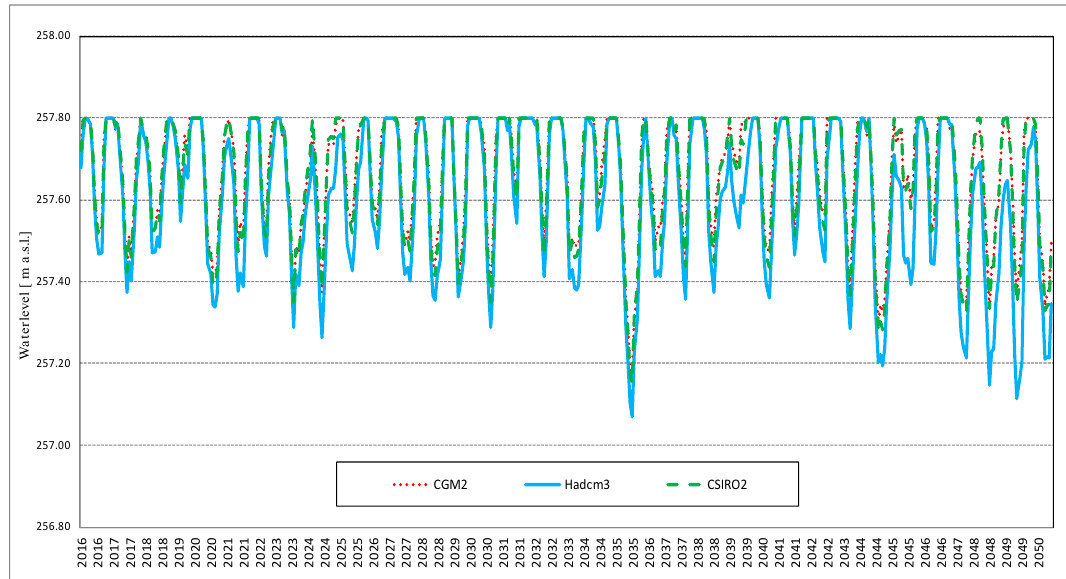
Figure 14. Predicted trends of Lake Trasimeno levels in the period 2016–2050, scenario A1F1.